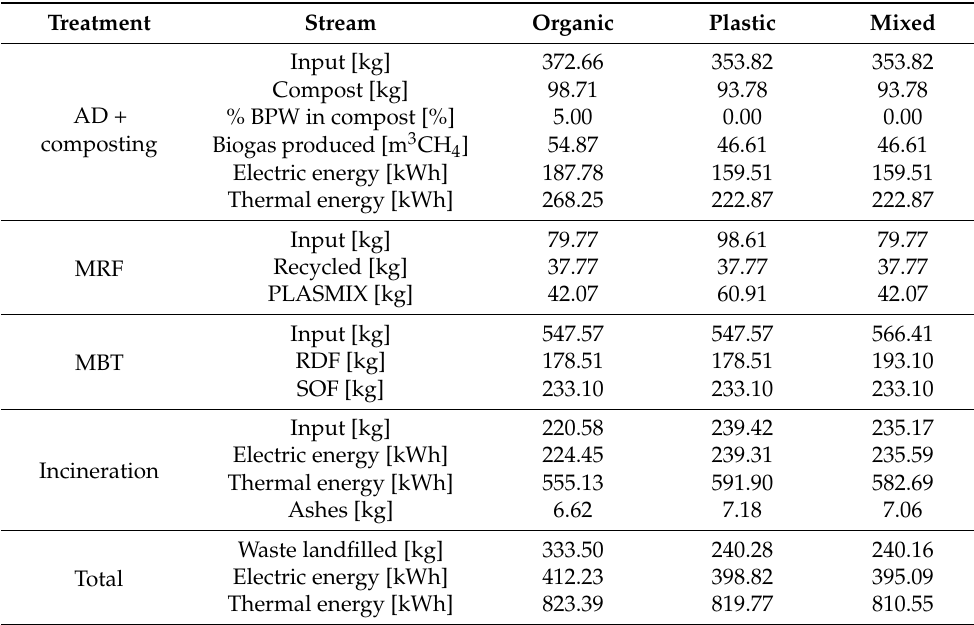
Table 2. Mass and energy inventory of organic, plastic and mixed waste treatment routes for every treatment.